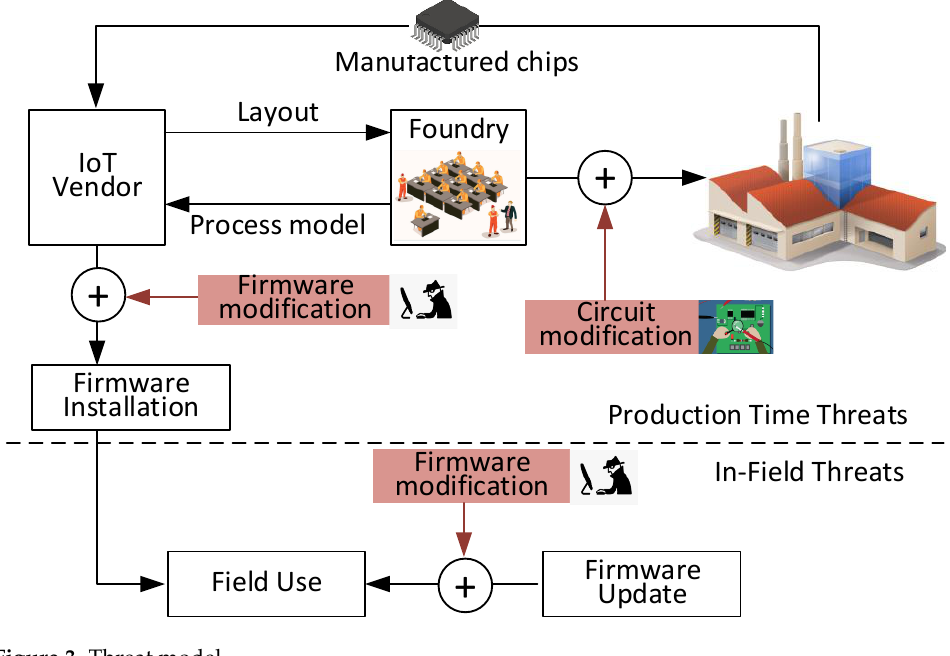
Figure 3. Threat